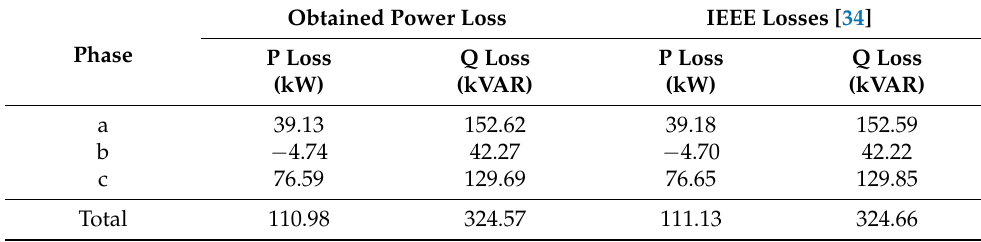
Figure 7. IEEE-13 bus URDN. Table 4. Power loss comparison for the IEEE-13 bus URDN. Table 5. Comparison of power flow solution with the IEEE solution for the IEEE-13 bus URDN .